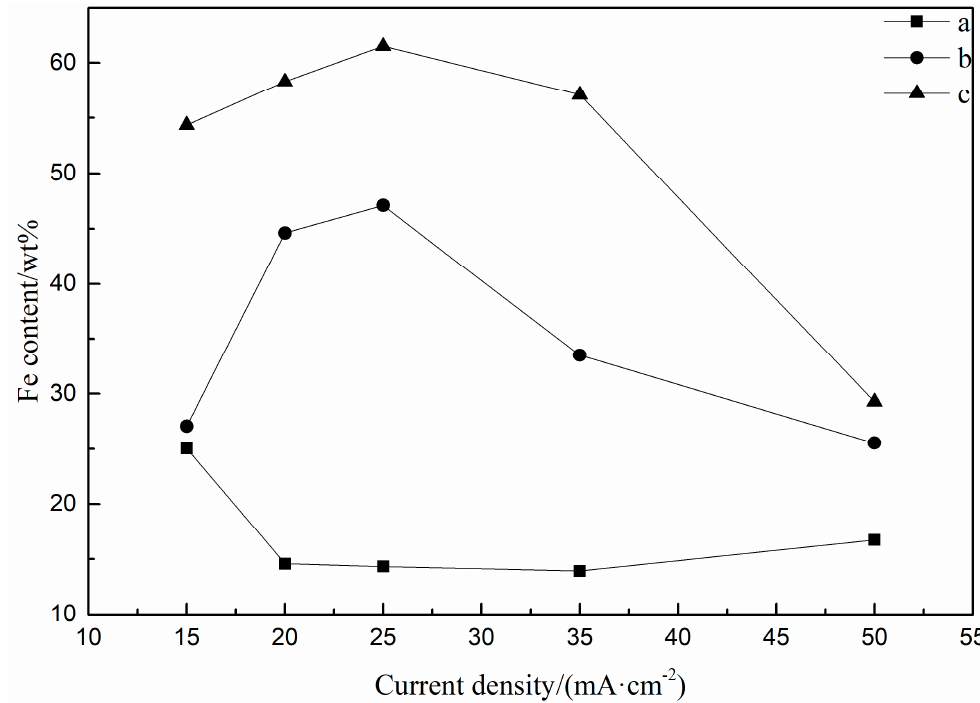
Figure 5. The relationship between Fe content in FeNi electrodeposited films and current density: